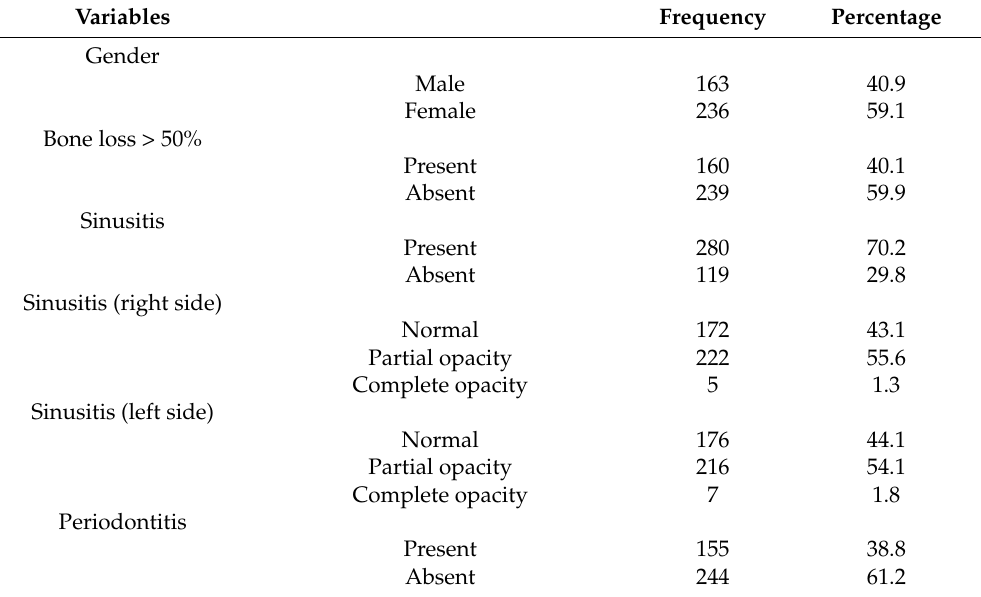
Table 1. Demographic distribution of the